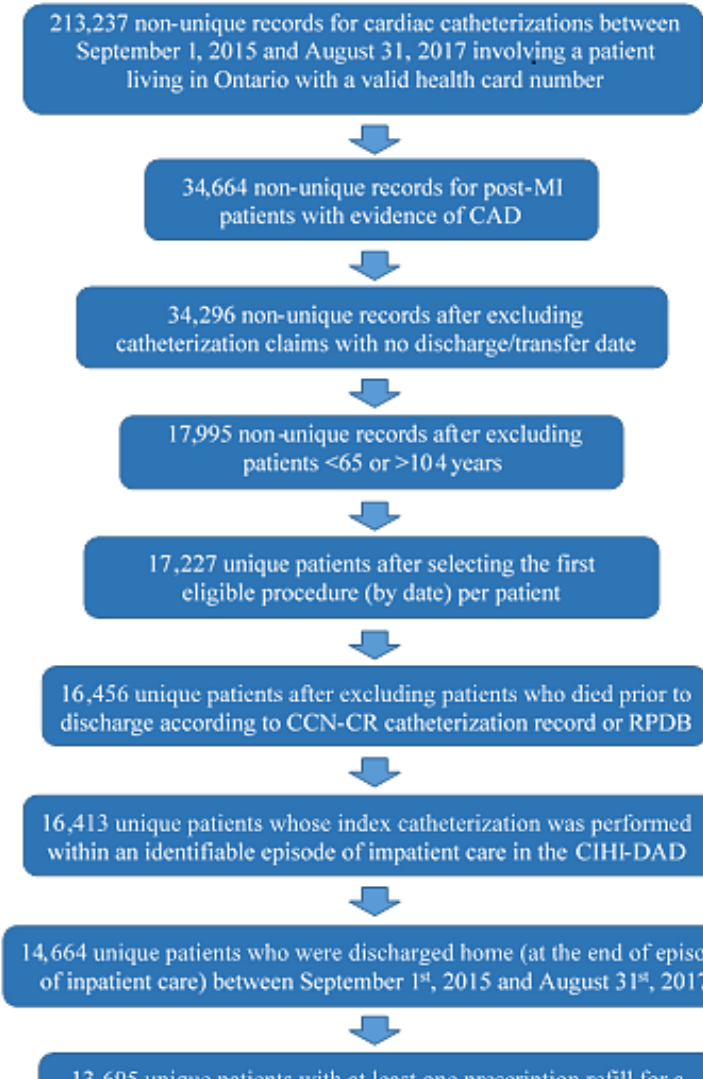
Figure 4. Flow of participants into the study during the pre-intervention period (preliminary data used for power calculation). Notes: Patient age determined at procedure date – 120 days. CAD: coronary artery disease; CCN-CR: Cardiac Care Network – Cardiac Registry; CIHI-DAD: